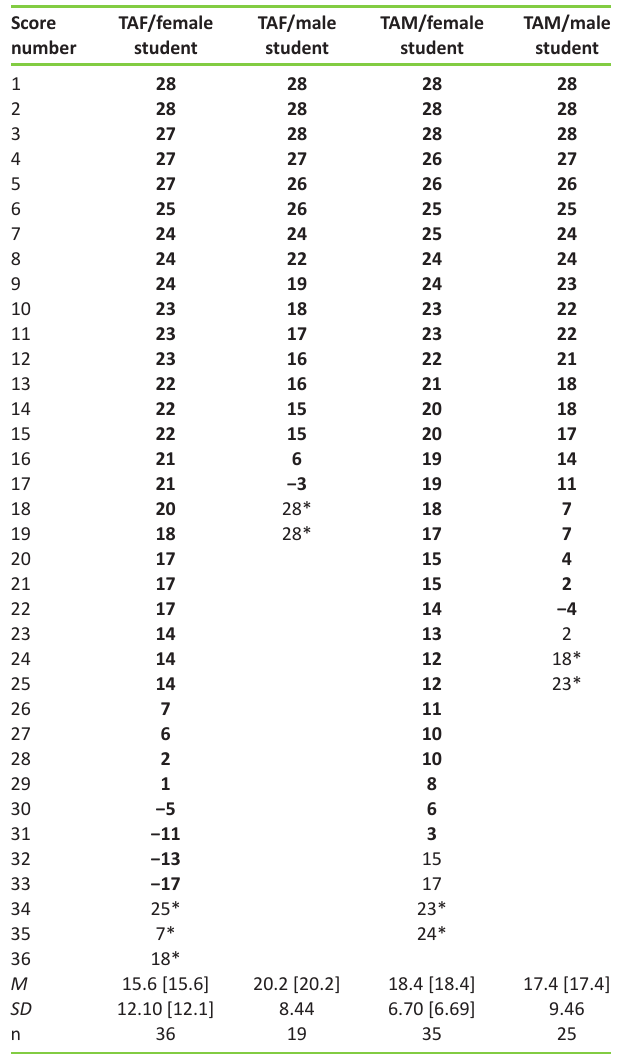
table 1: Khazan et al.’s [1] recovered data by condition and descriptive statistics, including descriptive statistics reported by Khazan et al.